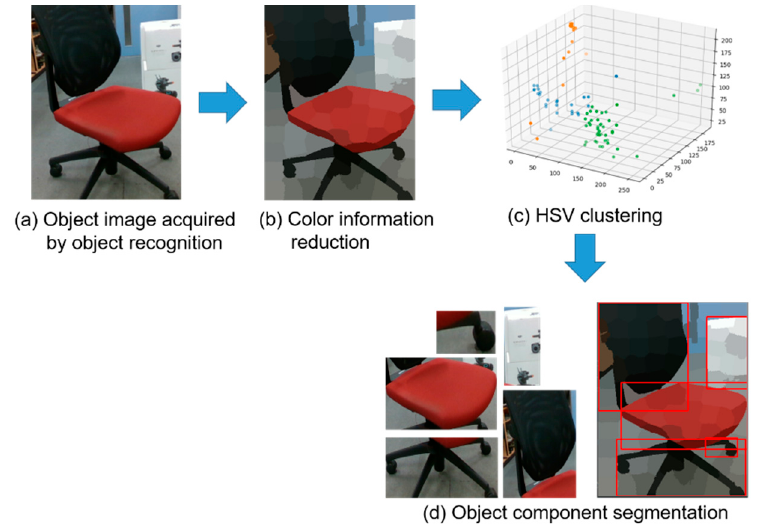
Figure 8. Process of object component segmentation.